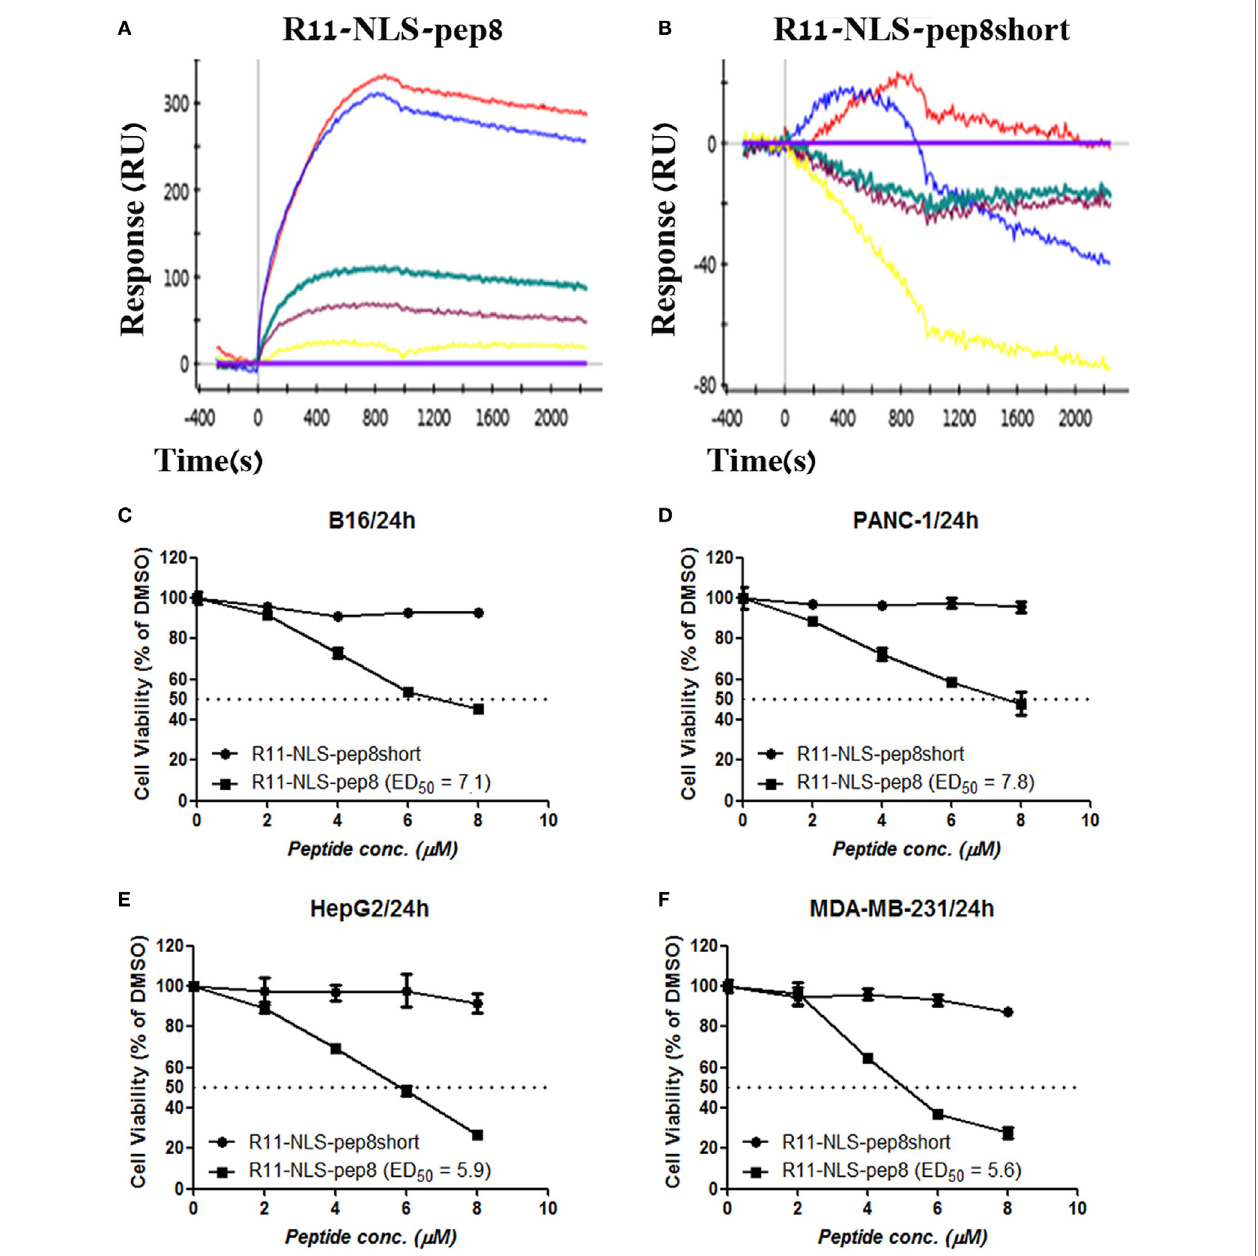
FigUre 3 | ProteOn based affinity array of R11-NLS-pep8 toward proliferating cell nuclear antigen (PCNA) and cell viability screening of human and murine cell lines. (a,B) ProteOn array result showing the binding of human PCNA at protein concentration range of; 0 nM (X base-line), 15.6 nM (yellow), 31.2 (purple), 62.5 nM (green), 125 nM (blue), 250 nM (red), to bond R11-NLS-pep8 and R11-NLS-pep8short, respectively. Murine B16 melanoma, human PANC-1 (pancreas ductal adenocarcinoma), HepG2 (liver hepatocellular carcinoma), and MDA-MB-231 (breast adenocarcinoma) cancer cell lines are used for checking the effect of R11-NLS-pep8 and R11-NLS-pep8short on cell viability in a PrestoBlue assay. The results are shown in respect to the basal viability indicated using equivalent % DMSO (background). ED50 was calculated using a sigmoidal dose–response curve. ED50 values were 7.1, 7.8, 5.9, and 5.6 µM, respectively, for B16, PANC-1, HepG2, and MDA-MB-231 (c–F)